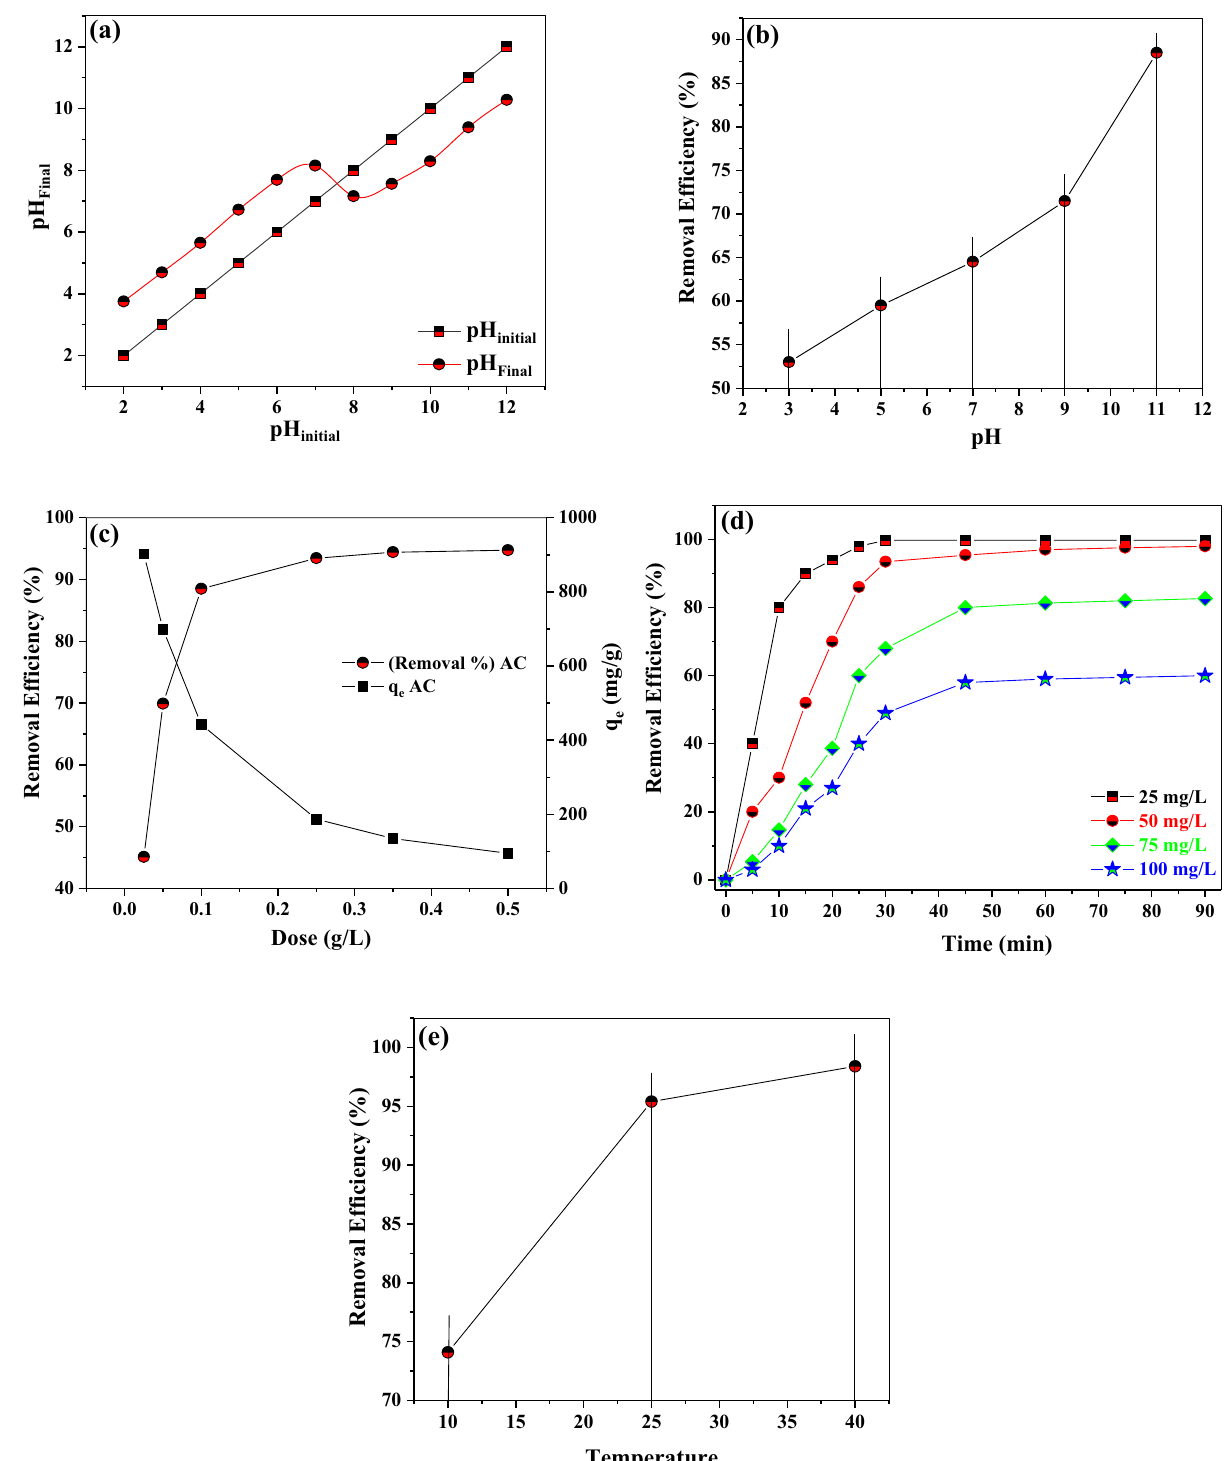
Fig. 3 PH zpc diagram of activated carbon ( a ), effect of pH changes ( b ), effect of adsorbent dose changes ( c ), effect of initial dye concentration ( d ) and effect of temperature on the absorption of cationic red 14 dye by activated carbon ( e